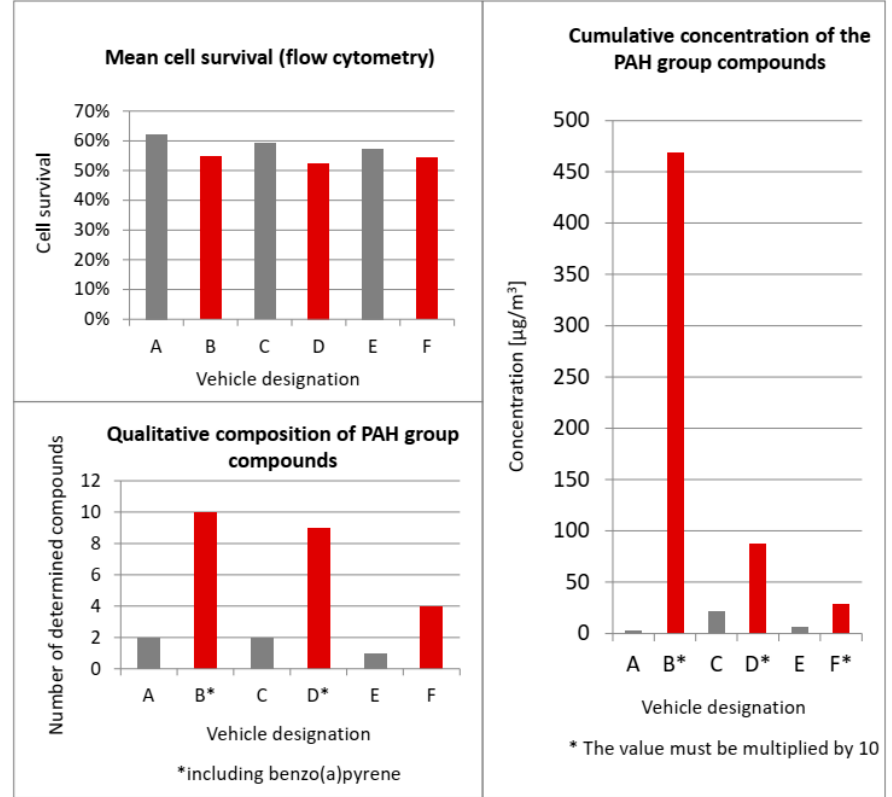
Figure 6. Correlations between the values of percentage cell survival and the number and cumulative concentration of compounds determined in the PAH group. Table 5. The HC and PAH contents in engine exhaust